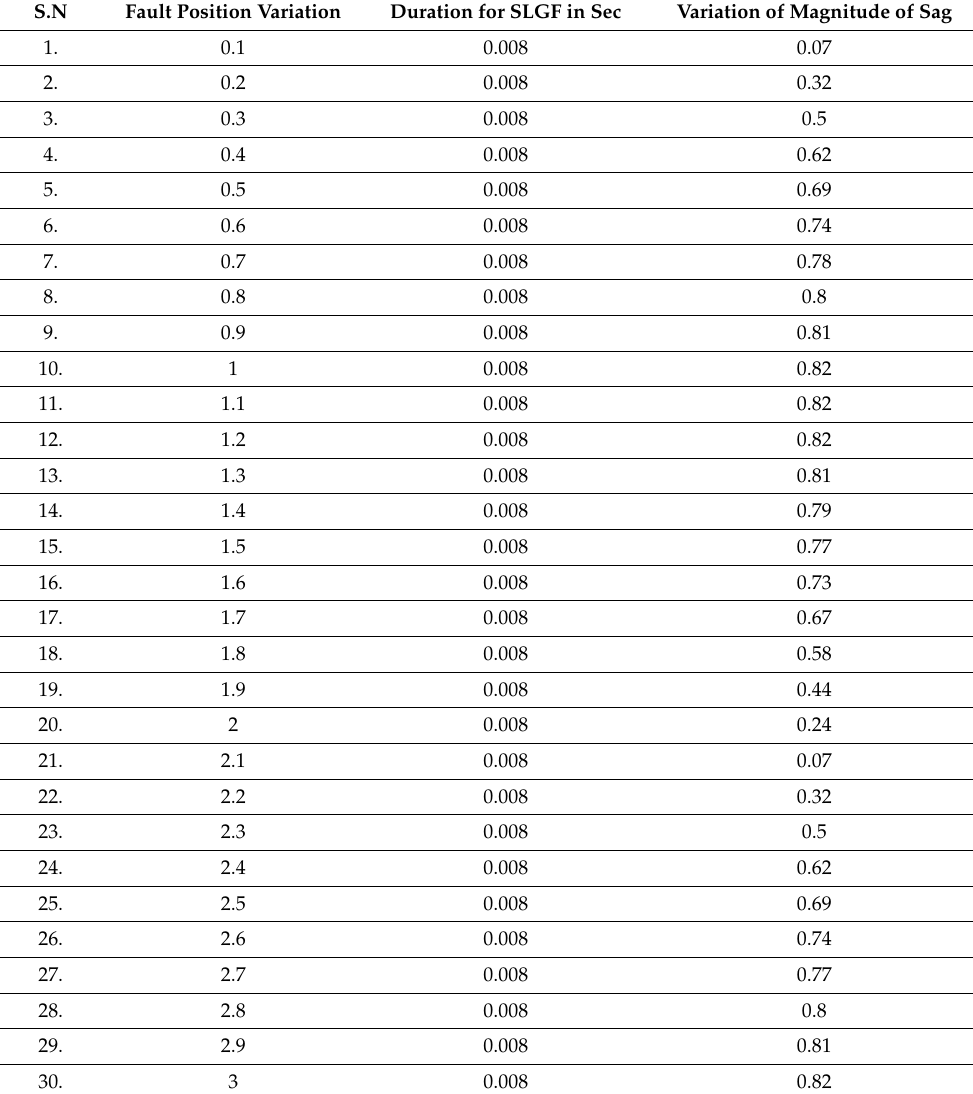
Table 2. Variation of sag magnitude concerning the change of fault position for the duration of 80ms. S.N